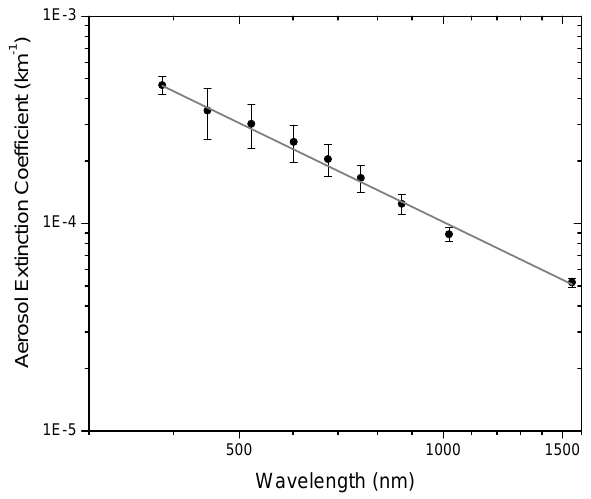
Fig. 4. An example of wavelength dependence of SAGE aerosol extinction coefficients (1 January 2005 at height 15.25km). Solid line corresponds to the best fit power law ( ˚Angstrom exponent) α = 1 . 58 ± 0 .